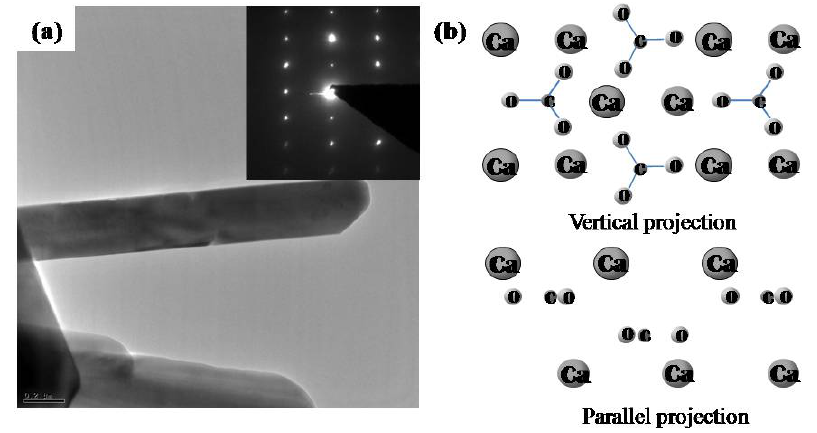
Figure 5. Transmission Electron Microscopy (TEM) image of needle-like aragonite and projection schemes of aragonite (010). (a) TEM image and Small Area Diffraction (SAD) pattern showing a single crystalline aragonite. (b) Vertical and parallel projection of aragonite